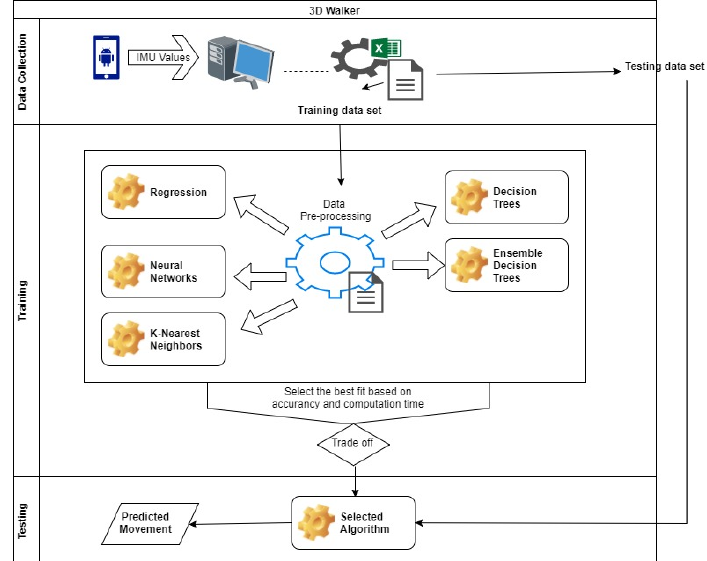
Figure 1. System Architecture.